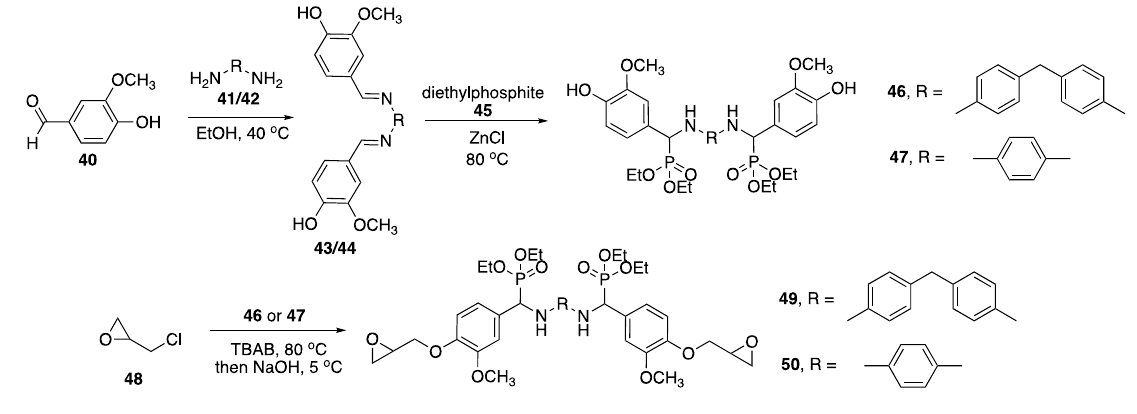
Figure 20. Preparation of 46, 47 , 49 , and 50 .